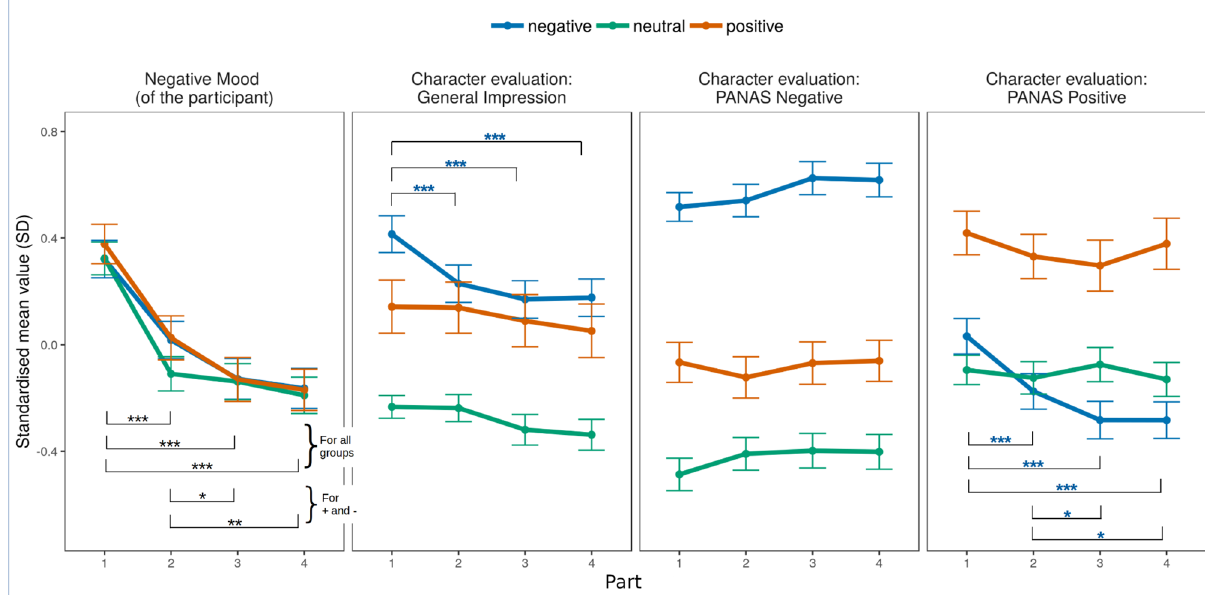
Figure 3. Changes over time in participants’ mood and character evaluations per valence group. Note : Significant pairwise tests for the repeated measures within groups are indicated by symbols. Follow-ups (study parts) took place approximately 2 days apart. Error bars represent the standard error of the mean. The general positive impression of the character was rated negative to